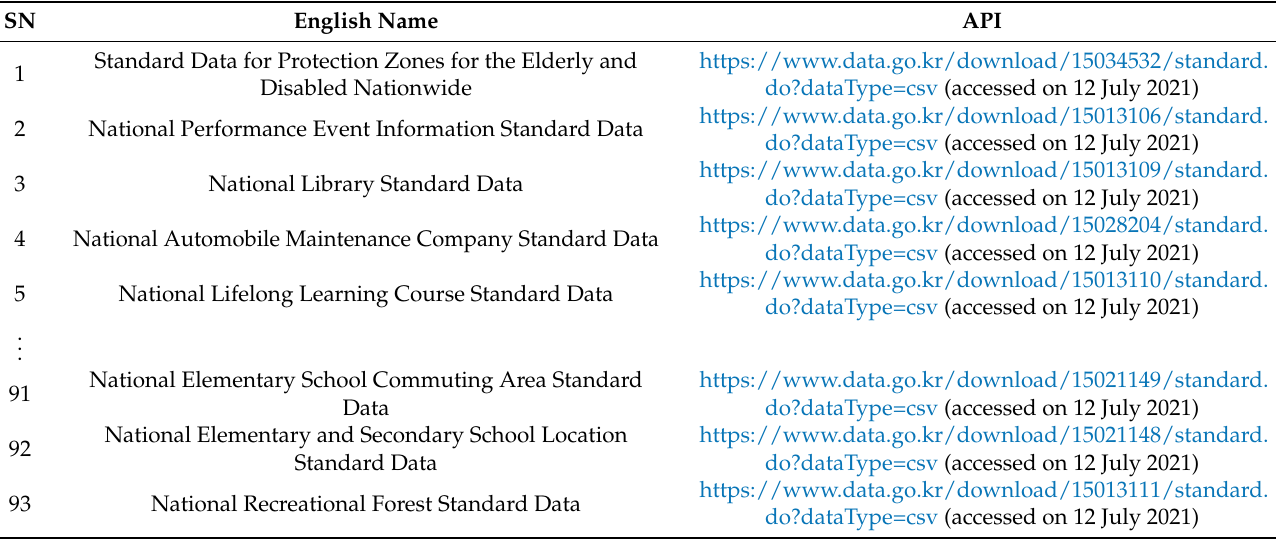
Table 1. List of standard data listed in ‘data.go.kr’ along with their download APIs stored in the API database.